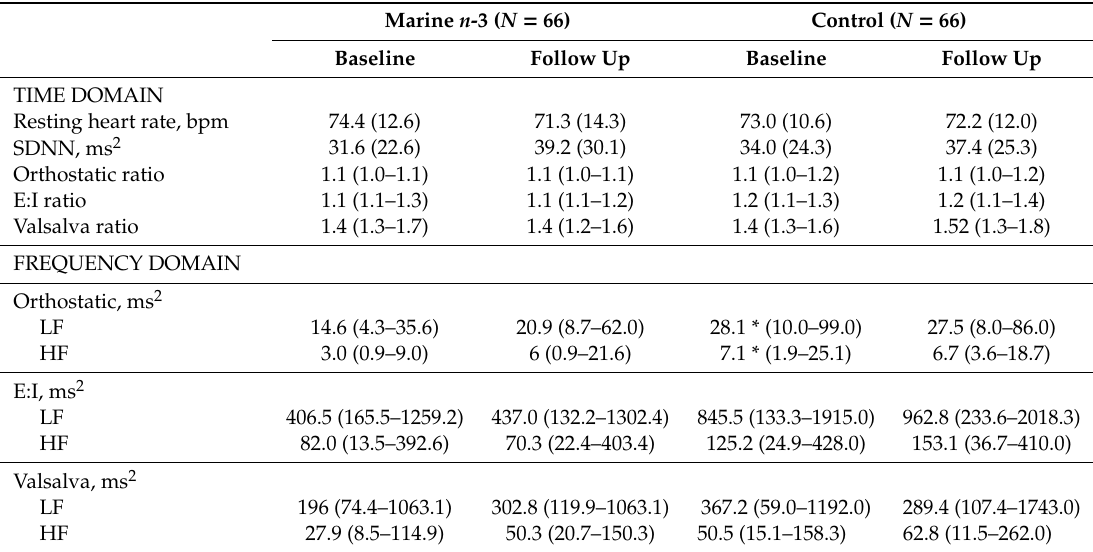
Table 2. Time and frequency domain heart rate variability (HRV) at baseline and at end of study.